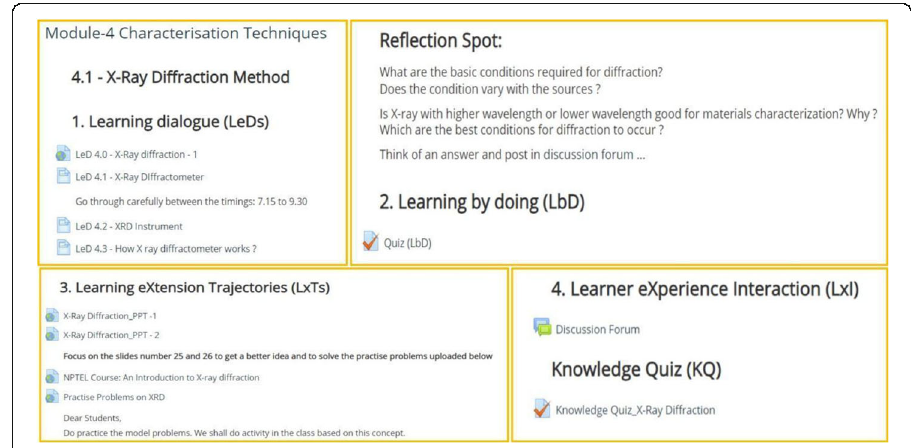
Fig. 3 Screenshot image of flip-phase activities for topic ‘ X-ray diffraction